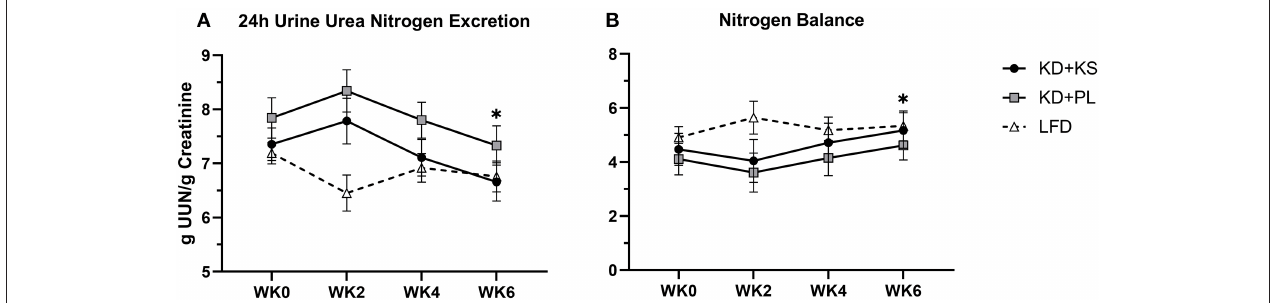
FIGURE 3 | Diet effects on urinary nitrogen and nitrogen balance. Solid lines are primary KD outcomes; dashed lines show LFD for comparison. Panels: (A) 24h urine urea nitrogen standardized per gram of creatinine; (B) nitrogen balance derived from validated formula. Primary analysis: 2 (group) × 4 (time) ANOVA. WK2 UUN was significantly higher than WK4 ( p < 0.05) and WK6 ( p < 0.01). Group effects show on average 8% lower UUN during KD + KS compared to KD + PL ( p = 0.082). With LFD included in the secondary 3 (group) × 4 (time) ANOVA analysis – Time effects: * p < 0.05 from WK0. Between-group effects: KD + PL had significantly higher UUN than LFD ( p = 0.004) and trended higher than KD + KS ( p = 0.076).